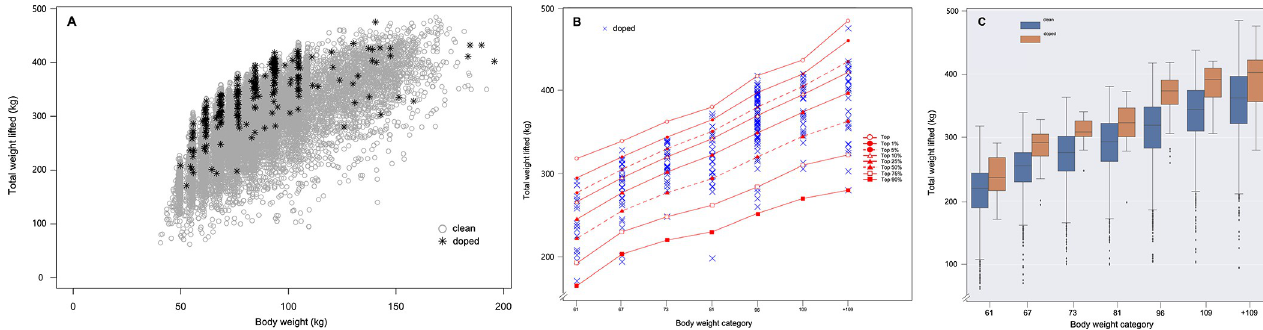
Fig 3. Male weightlifters’ performance in total weight lifted (kg) across body weight (26,740 results of not-sanctioned, 289 results of sanctioned). (A) Scatter plot showing the overall performance distribution for all athletes. Gray open circles represent results of not-sanctioned athletes, and black asterisks represent results of sanctioned athletes. (B) Body weight category analysis of performance (total weight lifted, kg) for male weightlifters. Solid line with open circles represents performance of the top athlete, solid line with filled circles represents athletes in the top 1%, dashed line with filled circles represents athletes in the top 5%, solid line with open triangles represents athletes in the top 10%, solid line with filled triangles represents athletes in the top 25%, dashed line with filled triangles represents athletes in the top 50%, solid line with open squares represents athletes in the top 75%, and solid line with filled squares represents athletes in the top 90%. Blue X’s represent results of sanctioned athletes. (C) Box plots of the average performance and outliers of each bodyweight category grouped by sanction status (not-sanctioned or sanctioned) for comparison. Boxes indicate the 25 th and 75 th percentiles. Whiskers indicate 10 th and 90 th percentiles with the middle horizontal line representing the mean. The outliers are indicated by